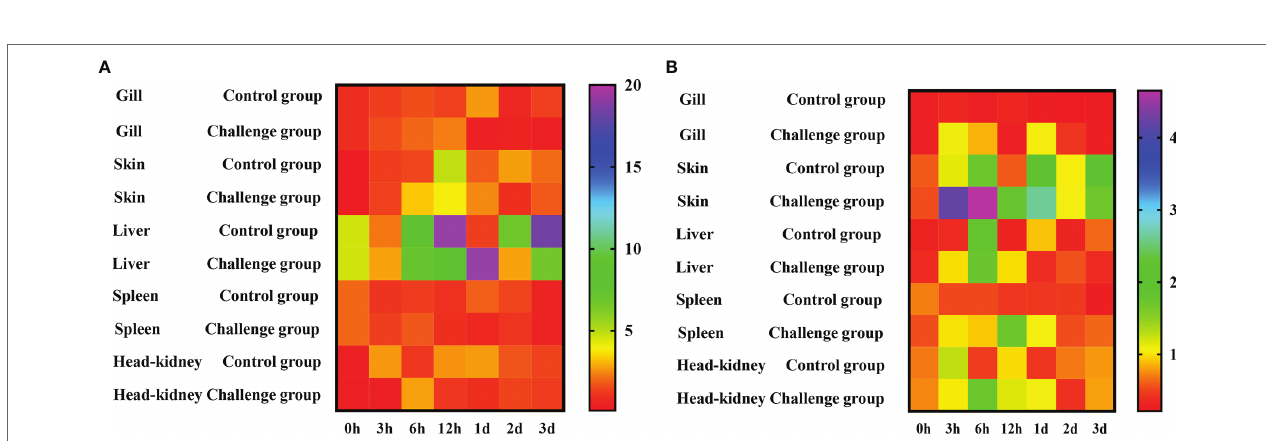
FIGURE 5 | Temporal expression of ToNF- κ B (A) and ToTNF α (B) mRNA is detected in gill, skin, liver, spleen, and kidney by qRT-PCR after infection with C. irritans (0, 3, 6, 12 hpi, 1 day, 2 days, 3 days). EF-1a is used as the internal control to calibrate the cDNA templates for all the samples. The heatmap is constructed by GraphPad Prism